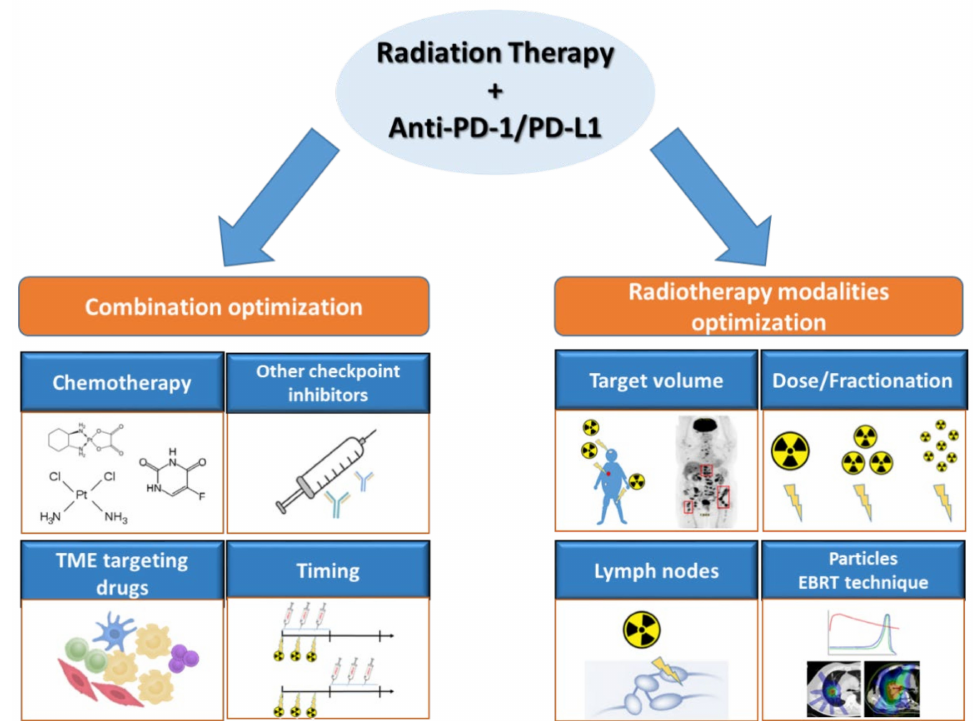
Figure 1. Optimization parameters for the association of radiation therapy and PD-1/PD-L1 blockade. This figure summarizes the title of the different points developed in this review. Abbreviations. TME: tumor microenvironment; EBRT: external beam radiation